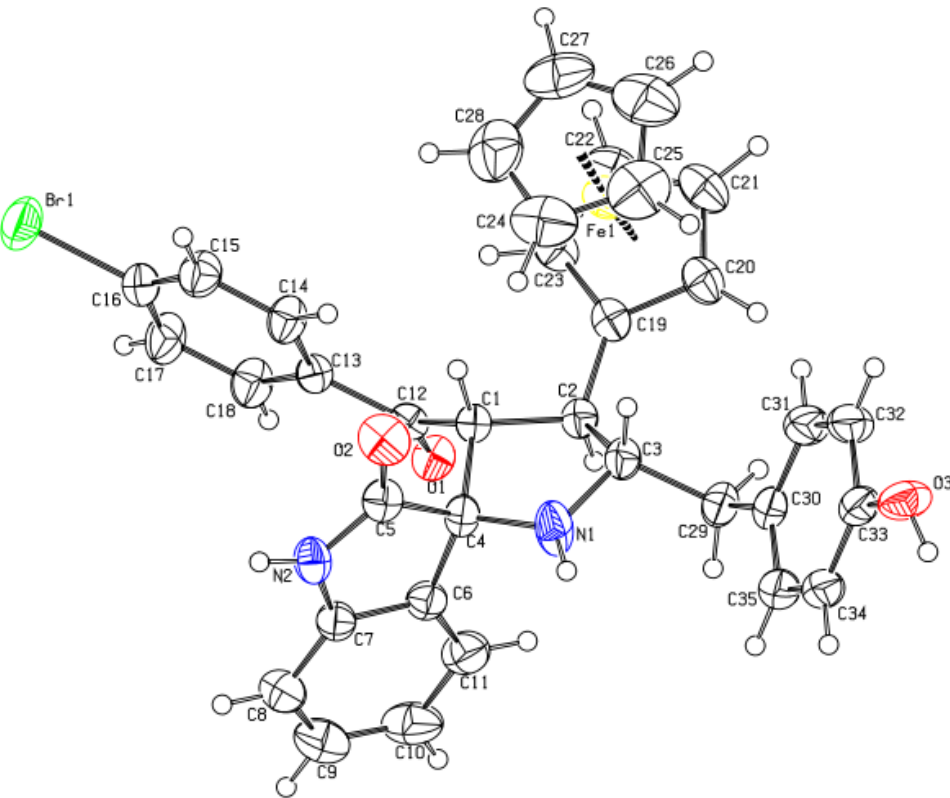
Figure 1. ORTERP diagram of 3a , where thermal ellipsoids were drawn at 40%.